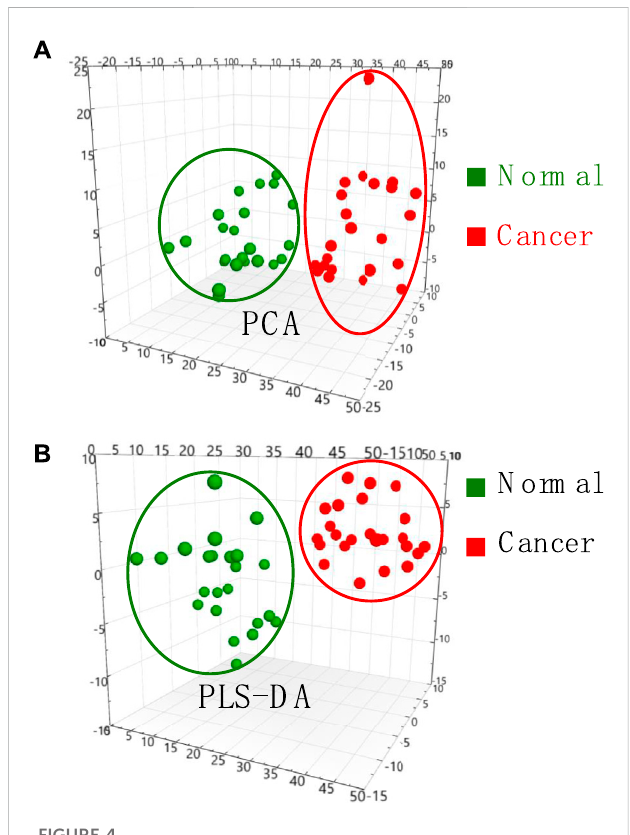
FIGURE 4 (A) PCA analysis and (B) PLS-DA analysis of MS data obtained from normal and cancer thyroid tissue